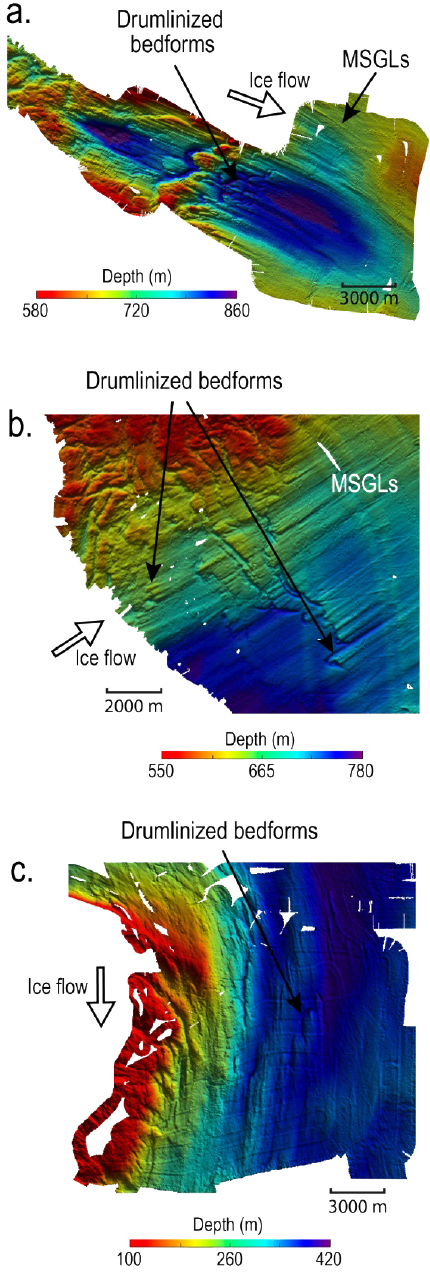
Figure 3. Close-up on the seabed morphology and swath bathymetry perspective views. The location of (a) – (c) is presented in Fig. 2. Offshore topography is gridded at 25m and shown with a vertical exaggeration of X3. (a) Bathymetry image shows the Cold Seep Basin region with drumlinized bedforms and mega-scale glacial lineations (MSGLs) associated with a paleo-ice-flow direc- tion, (b) Scar Inlet, and (c) Cape Framnes, south of the Jason Penin- sula. The paleo-ice-flow direction is indicated by the white arrows.